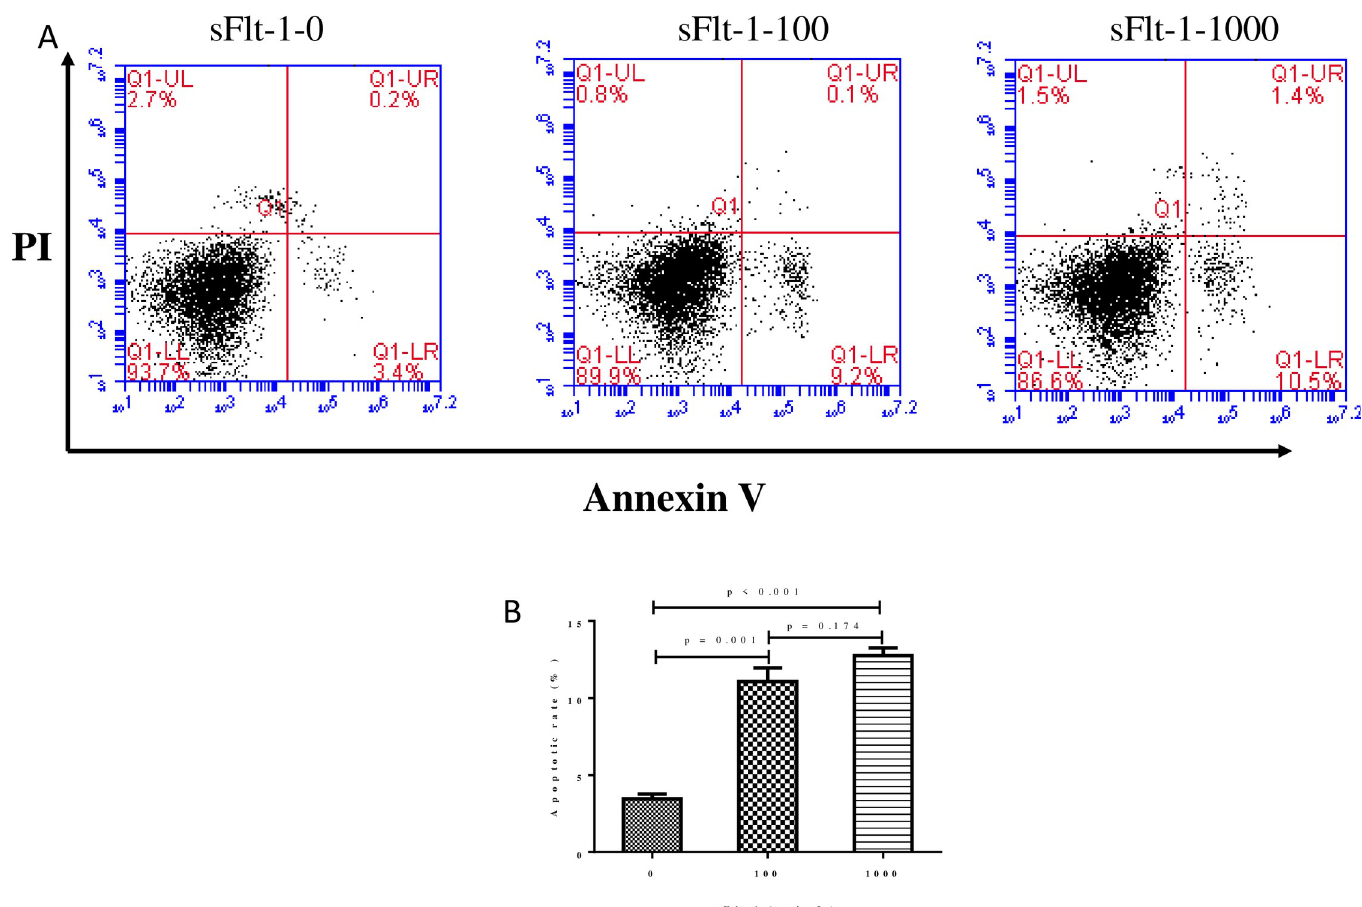
Fig 4. The apoptosis rate of HUVECs was measured using an Annexin V-APC apoptosis analysis kit. The apoptosis of HUVECs was detected by flow cytometry. The figure showed a representative set of the dot-plot graph of flow cytometry analysis of the following groups: A: the indicated concentrations of sFlt-1-treated group, and B: statistical result of apoptosis rate of HUVECs in different groups. The apoptosis rate was up-regulated significantly as the stimulation concentrations of sFlt-1 increased (100 ng/ml vs. 0 ng/ml, 11.07 ± 1.57% vs. 3.47 ± 0.51%, p = 0.001; 1000 ng/ml vs. 0 ng/ml 12.77 ± 0.85% vs. 3.47 ± 0.51%, p < 0.001). There was no obvious difference between cells with 1000 ng/ml and 100 ng/ml (12.77 ± 0.85% vs. 11.07 ± 1.57%, p = 0.174). Results are the means ± standard deviation of three independent experiments.